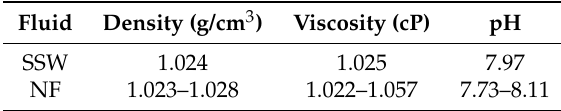
Table 2. Fluid properties measured at room temperature (20 ◦